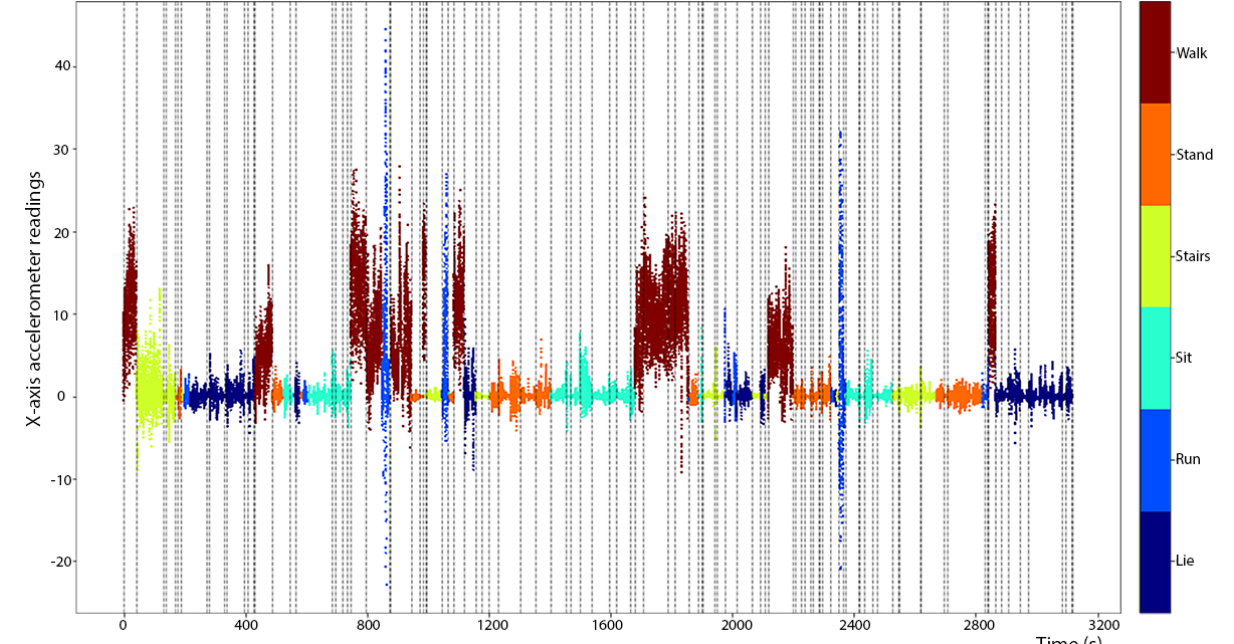
Figure 12. Multivariate segmentation break points (K=100) displayed using vertical dashed lines on the time series of x-axis accelerometer readings from experiment 1 in the BREATHE training